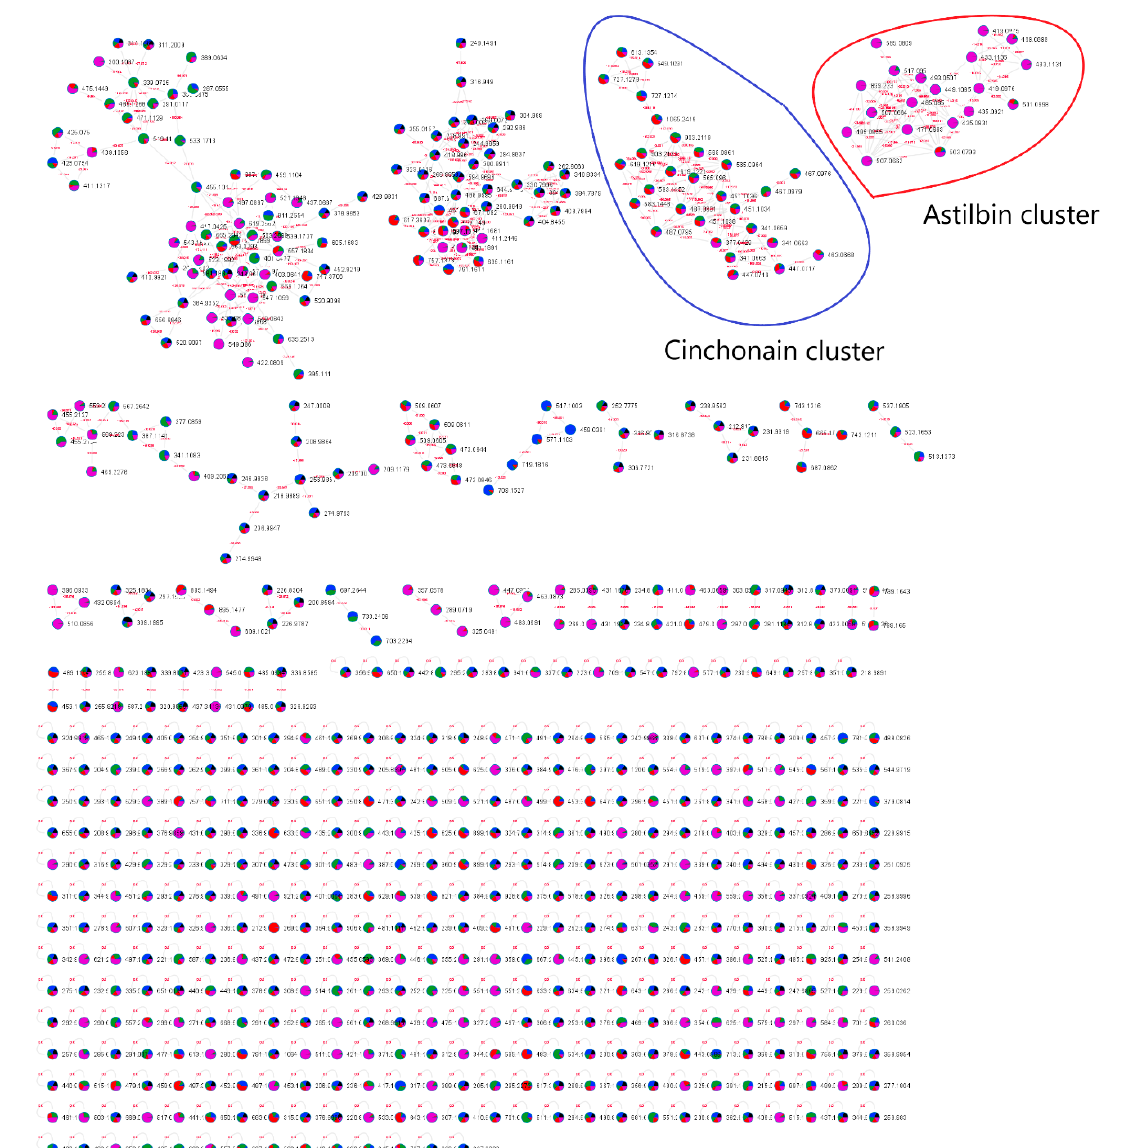
Figure 1. Molecular networking of different methanolic extracts from Anomalocalyx uleanus with MS 2 data obtained in the negative mode and clustered by the Cytoscape 3.80 software and emphasizing the main compound annotations obtained from the GNPS and METLIN libraries. Color nodes: roots (blue), bark (green), stem bark (red), leaves (purple), and blank (black).